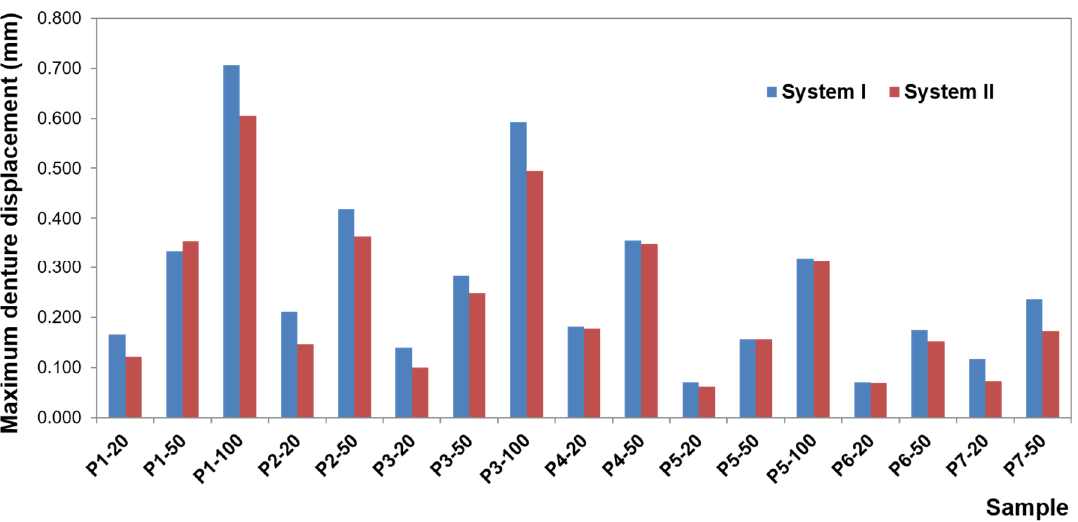
Figure 8. Maximum denture displacement in the first and second system.